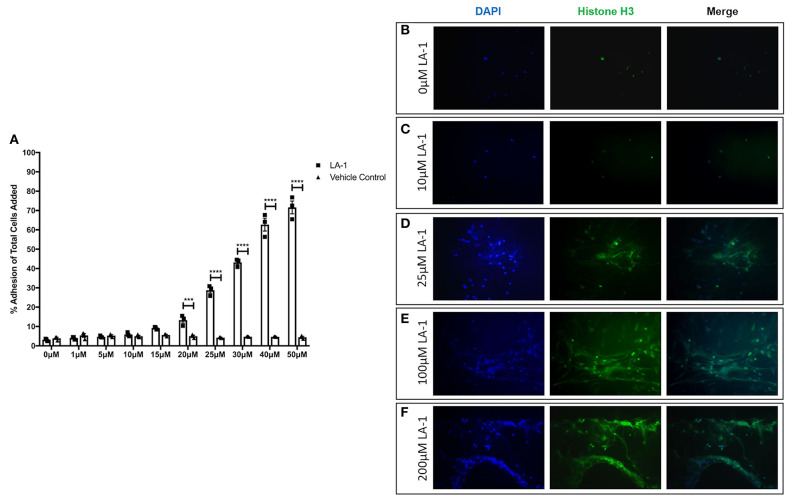
Specific αMβ2 activation induces NET-like structure release. The effects of specific αMβ2 activation upon on neutrophil function by culturing cells with varying concentrations of leukadherin-1 (LA-1). (A) Lower concentrations (0–15 μM) of LA-1 did not increased neutrophil adhesion compared to vehicle. From 20 to 50 μM LA-1, we observed a dose dependent increase in neutrophil adhesion. Data are presented as the mean ± SEM from three independent experiments and analyzed by two-way ANOVA with a Sidak's multiple comparison test. The release of NET-like structures was visualized by staining nuclear DNA (DAPI, blue staining) and histone H3 (green staining) in neutrophils. (B) Untreated neutrophils and (C) neutrophils stimulated with 10 μM LA-1 displayed punctate nuclear staining. (D) 25 μM LA-1 stimulation induced greater neutrophil adhesion, however nuclear staining was still punctate. (E) Greater numbers of neutrophils were seen following stimulation with 100 μM LA-1 with the addition of externalized DNA and histone staining, forming NET-like structures. (F) 200 μM LA-1 stimulation also induced NET releasing neutrophils. Representative images are shown from two independent experiments. *** = p = 0.0003, **** = p < 0.0001.